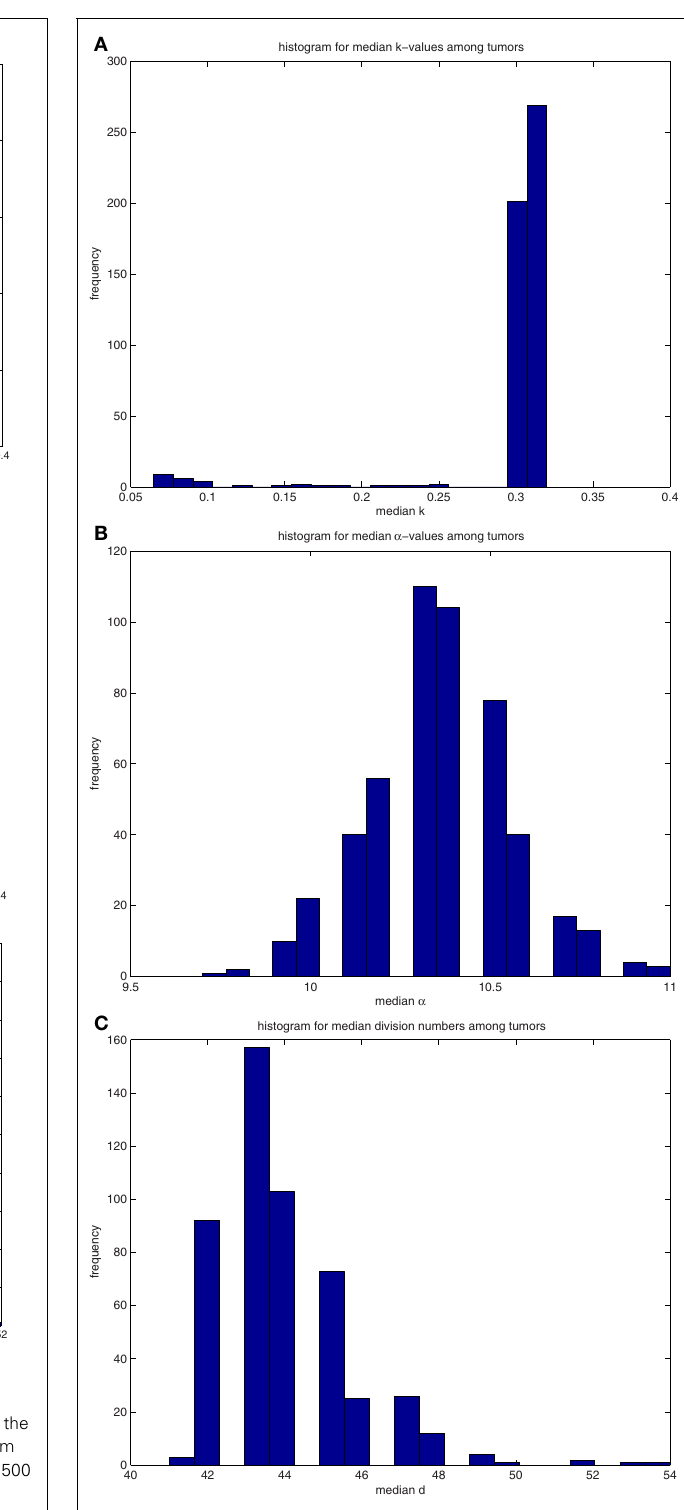
FIGUREA4 | (A) Histograms for the median values of differentiation coefficient k from 500 tumors spawned fromTICSCs. (B) Histograms for the median values of proliferation potential α from 500 tumors spawned fromTICSCs. (C) Histograms for the median values of division number d from 500 tumors spawned